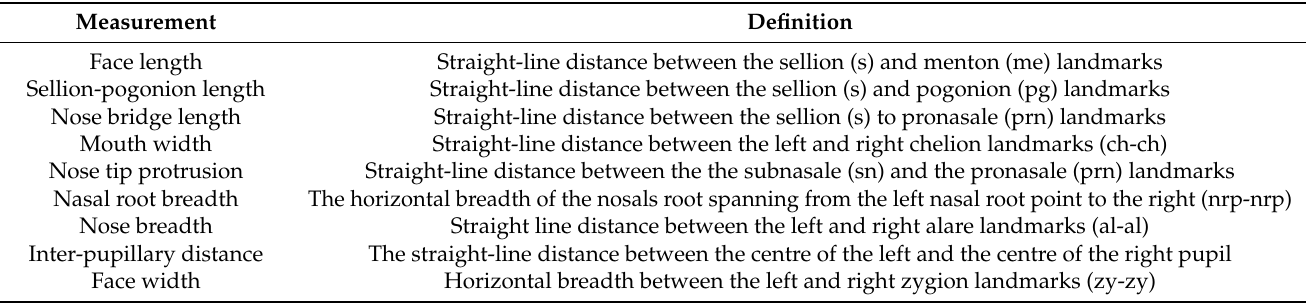
Table 2. Definitions of the nine selected measurements for the measurements based